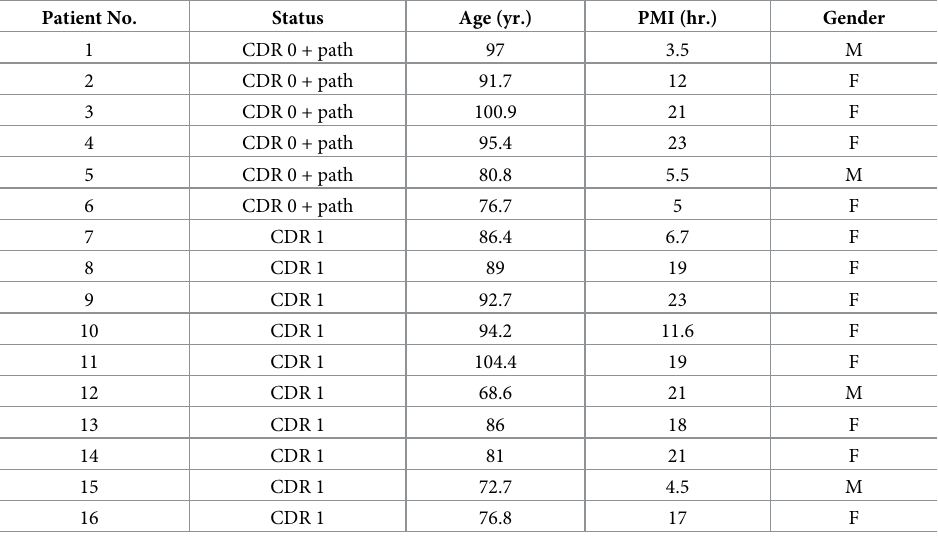
Table 1. Characteristics of human brain frontal cortex samples. Patient